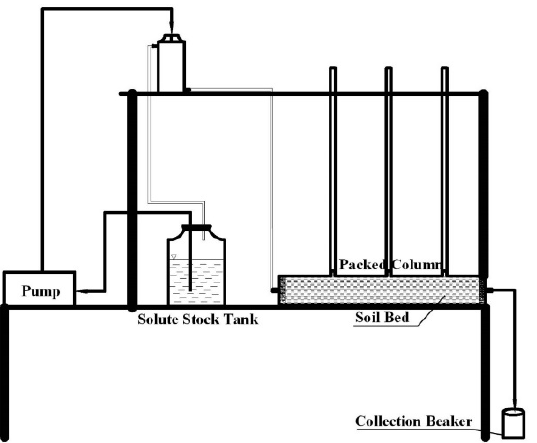
Figure 2. Schematic of the experimental equipment for contaminant transport in groundwater.